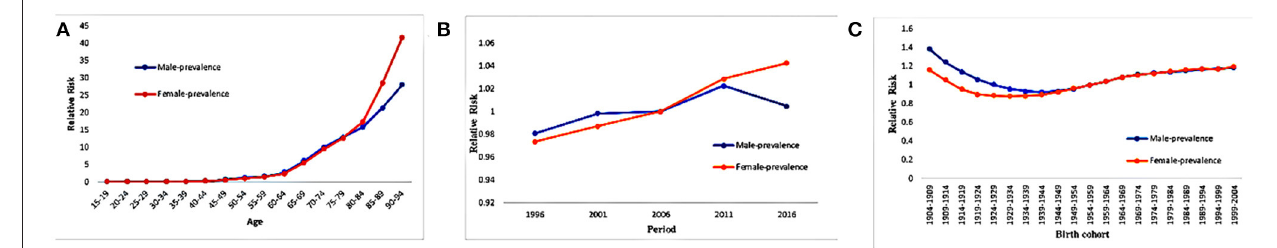
FIGURE 1 | Hypertensive heart disease prevalence relative risks due to (A) age; (B) period; (C) cohort